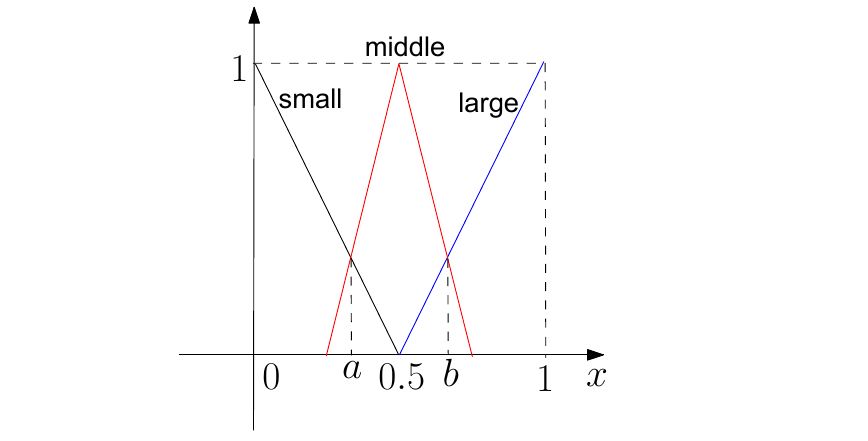
Figure 6. Fuzzy numbers and their membership functions in iDRF-1.